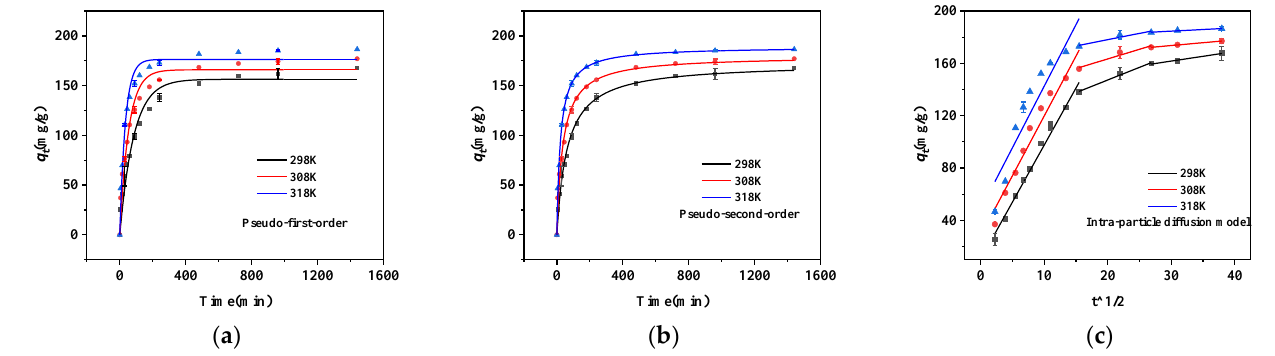
Figure 5. Adsorption kinetics study. ( a ) Pseudo-first-order model, ( b ) pseudo-second-order model, and ( c ) intra-particle diffusion model.